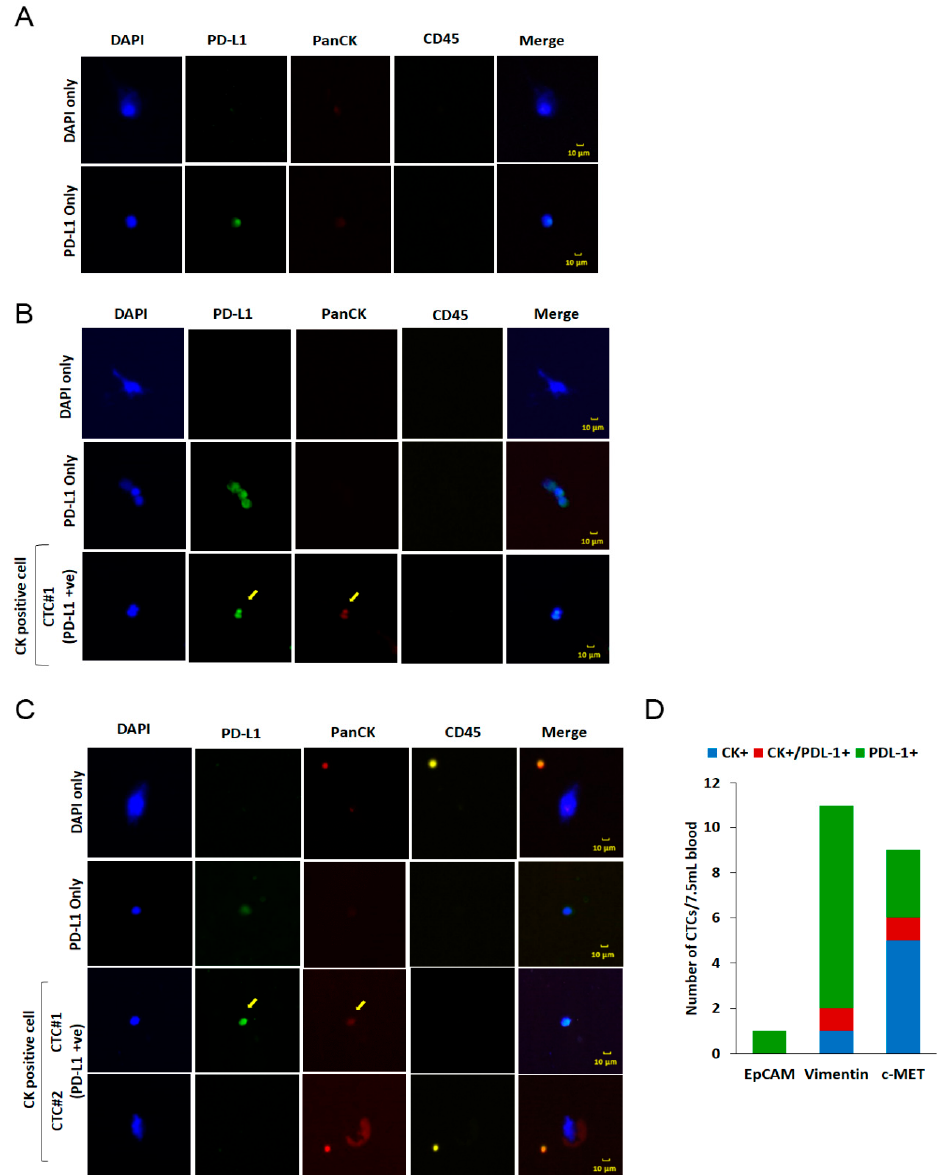
Figure5. IsolationandcharacterizationofCTCsfromacholangiocarcinomapatient: ( A )Immunofluorescence image showing EPCAM-positive cells isolated from a cholangiocarcinoma patient. EPCAM-positive cells were immunostained with DAPI for nuclear staining (blue), an anti-PDL1 antibody (Alexa flour 488; Green), and an anti-Pan CK antibody (Alexa flour 594; Orange red) to detect CTCs; an anti-CD45 antibody was used for leukocytes (Cy3; Yellow). ( B ) Vimentin-positive cells isolated from a cholangiocarcinoma patient were immunostained with DAPI for nuclear staining (blue), an anti-PDL1 antibody (Alexa flour 488; Green), and an anti-Pan CK antibody (Alexa flour 594; Orange red) to detect CTCs; an anti-CD45 antibody was used for leukocytes (Cy3; Yellow). ( C ) MET-positive cells isolated from a cholangiocarcinoma patient were immunostained with DAPI for nuclear staining (blue), an anti-PDL1 antibody (Alexa flour 488; Green), and an anti-Pan CK antibody (Alexa flour 594; Orange red) to detect CTCs; an anti-CD45 antibody was used for leukocytes (Cy3; Yellow). The yellow arrow indicates CK +/ PDL1 + cells. All microscopic images were obtained using a Nikon Eclipse Ni microscope equipped with an Infinity3 camera. ( D ) Graph showing the di ff erence in CTC counts determined using EPCAM-, vimentin- or ME-based methods. The number of PDL1-positive CTCs observed in each case is also